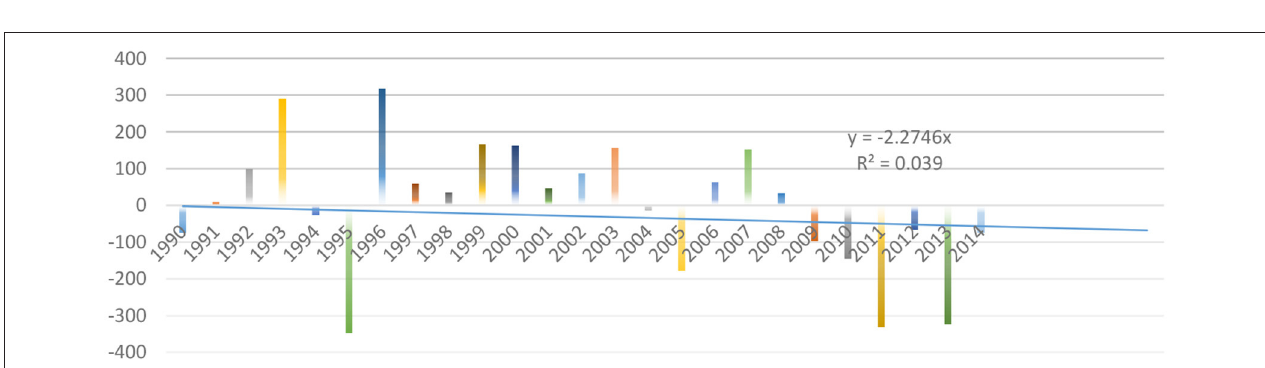
FIGURE 2 | Observed temperature trend and anomalies in Fundong.